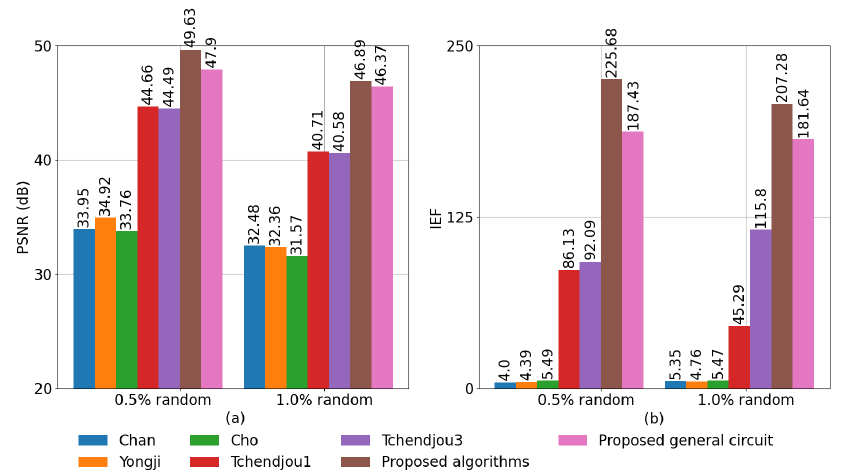
Figure 16. Comparison of defective pixel detection/correction methods using ( a ) PSNR and ( b )